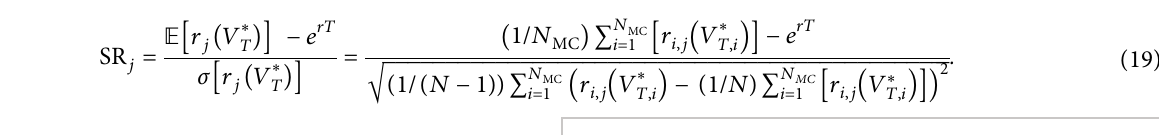
Figure 2: Sharpe ratio sensitivity to ϵ